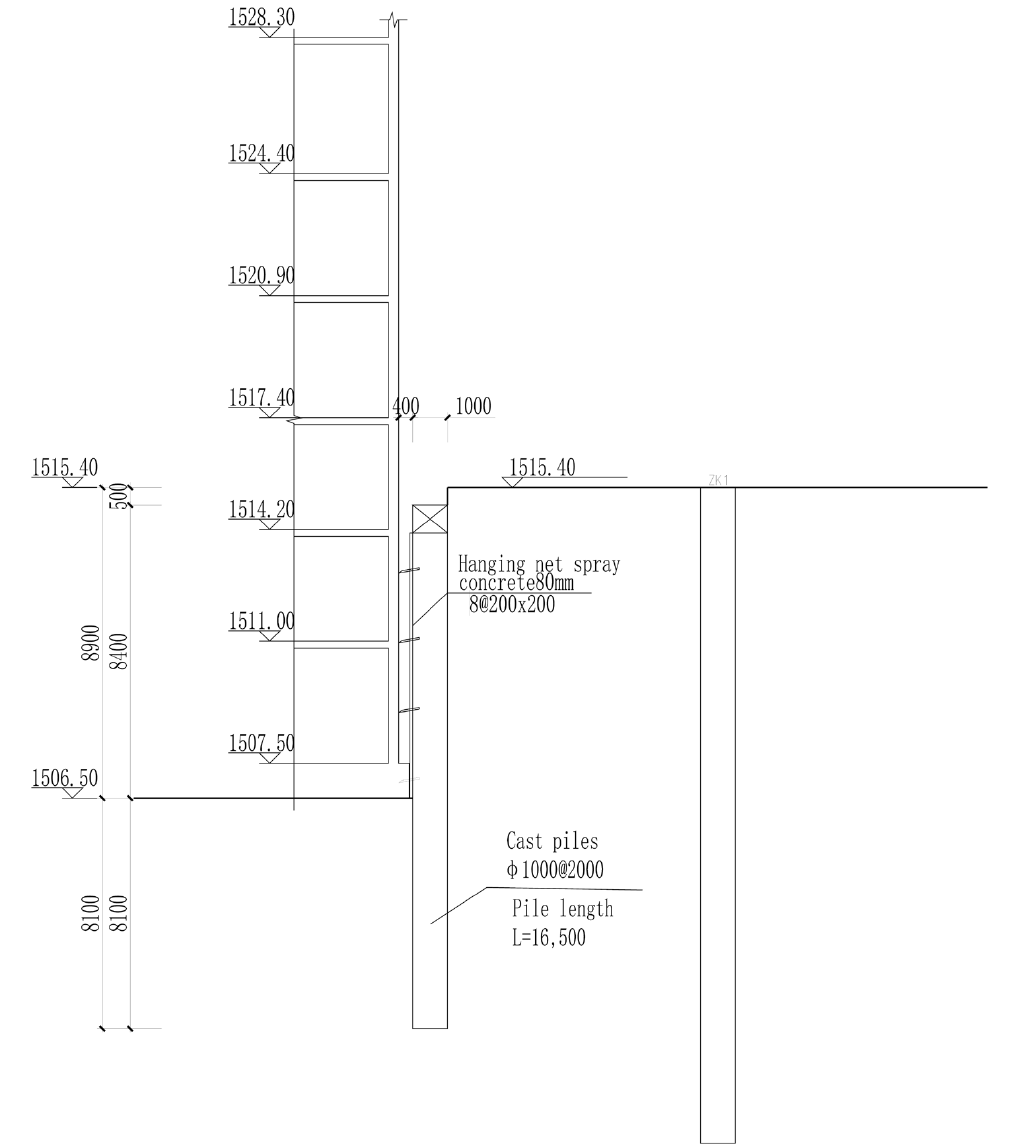
Figure 2. Profile view of a typical support structure.